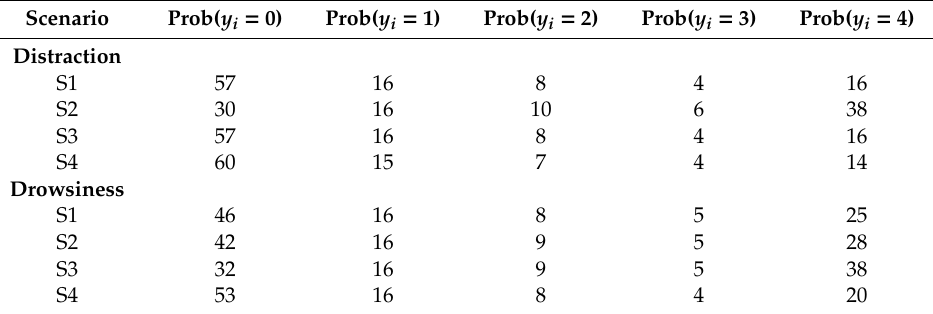
Table 5. Probabilities of the outcomes of the OPM for di ff erent